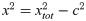
The concentrations of minor fragments x and xtot at division events for Y-dominant cells as a function of D.Free [red] and Total [green] indicate x and xtot, respectively. For the free fragments [x], the results of simulations [red curves with points for VDiv = 103 and 104] agree well with the solution x2=xtot2-c2 from Eq (13) [red curve]. For the total fragments [xtot], the simulations [green curves with points for VDiv = 103 and 104] agree with the solution xtot2 of Eq (13) [green curve] for larger D, but shift to larger values for smaller D. This is because cells must possess at least one catalyst to divide, therefore, the total fragments including c shift to larger values as it approaches the minimum requirement. Note that xtot2<1/2, and the concentration of major fragments is obtained by xtot1=1-xtot2. For reference, the values of xtot = 1/VDiv at which the number of c is equal to one for VDiv = 103 and 104 are shown by horizontal dotted lines, respectively. The other parameters are Ncell = 100, kf = kb = 1, and kx = ky = k = 1.